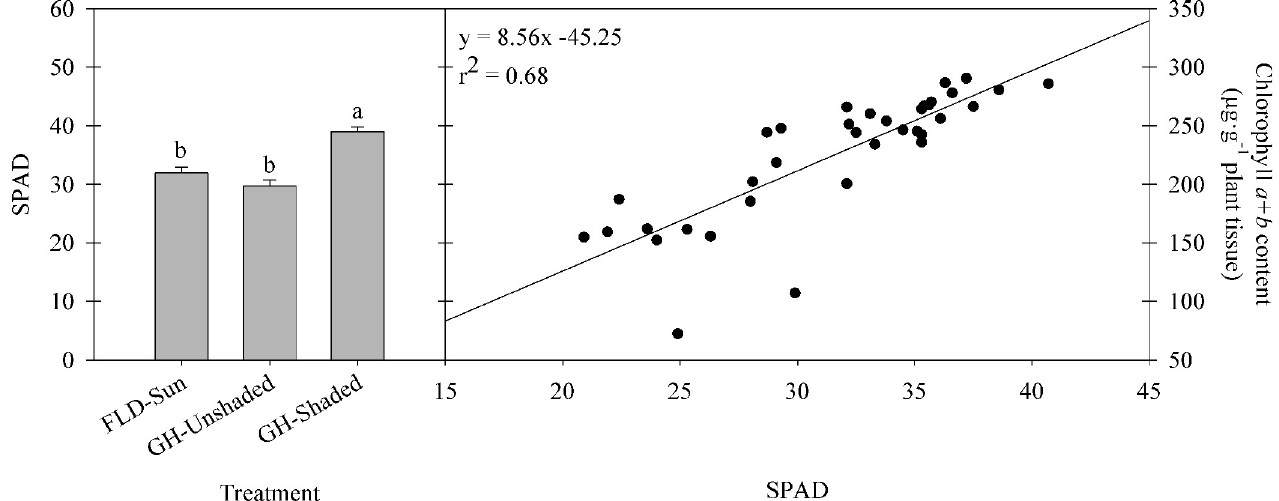
Fig 5. SPAD index value and correlation of SPAD and chlorophyll a+b content in kratom leaves. SPAD index measurements were pooled from four random replicates per treatment for four months (n = 48) and chlorophyll correlation data were pooled from nine random replicates for four months (n = 36). Plants were cultivated from September to December 2018 under different radiation treatments. Means sharing the same letter are not statically different by Tukey’s honest significant difference test at P < 0 . 05 . Error bars indicate the standard error.